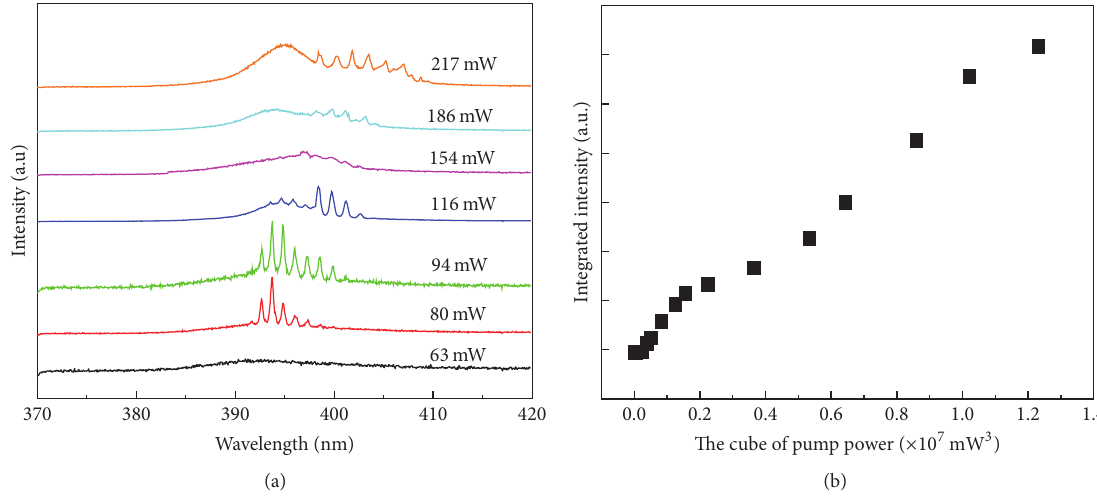
Figure 2: (a) The emission spectra at different pump power and (b) the variation of the spectrum integrated intensity with the cube of pump